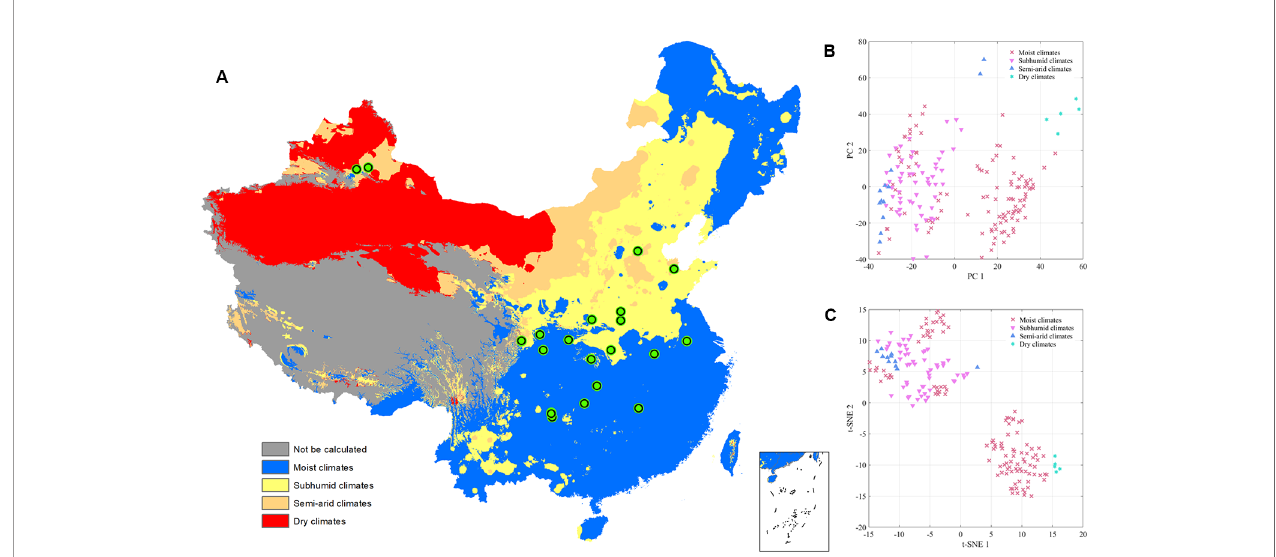
FIGURE 5 | The exploratory analysis results of Eucommia ulmoides leaves (EUL) samples in dryness (A) : The distribution of each collection site; (B) : PCA; (C) :